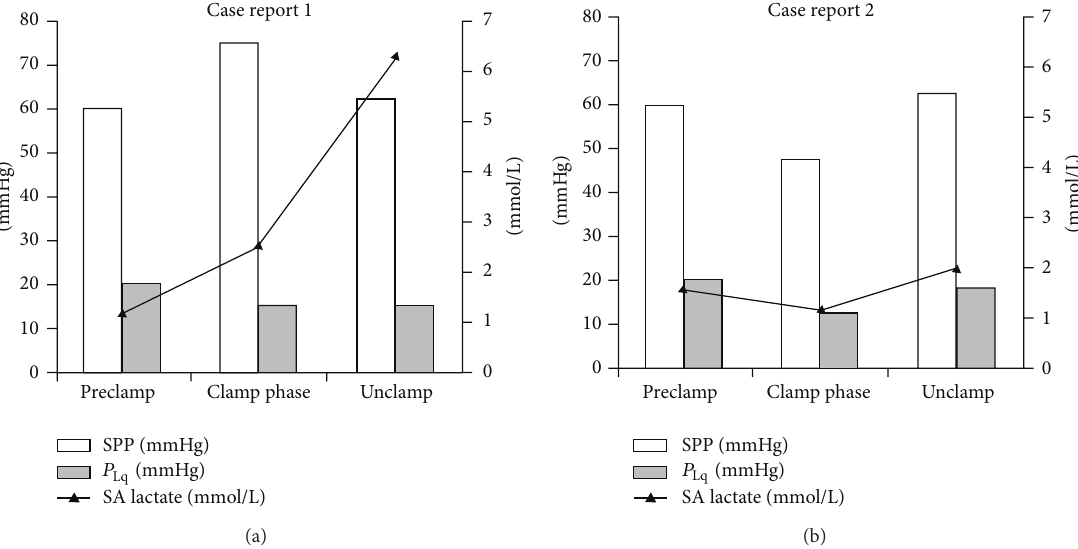
Figure 1: Subarachnoid pressure and Lactate. SPP=Spinal perfusion pressure (MAP- 𝑃 level in subarachnoid